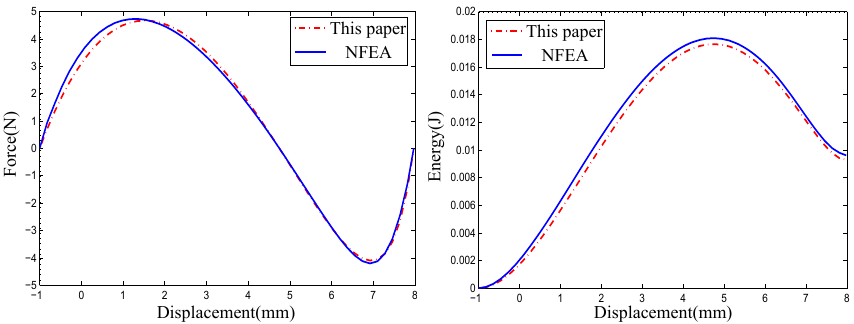
Figure 10. The comparison of the bistable kinetostatic behaviors achieved using NFEA and the tri-root bistable function.